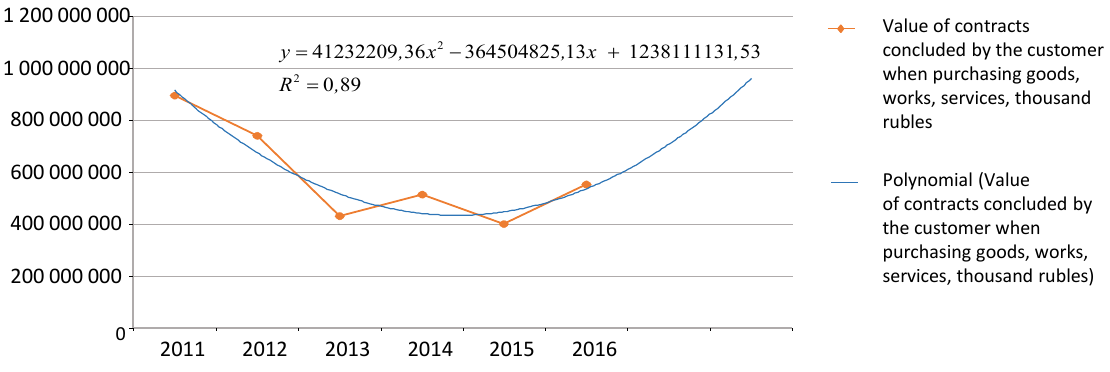
Figure 1. Cost of procurement contracts for goods, works and services in JSC “Russian